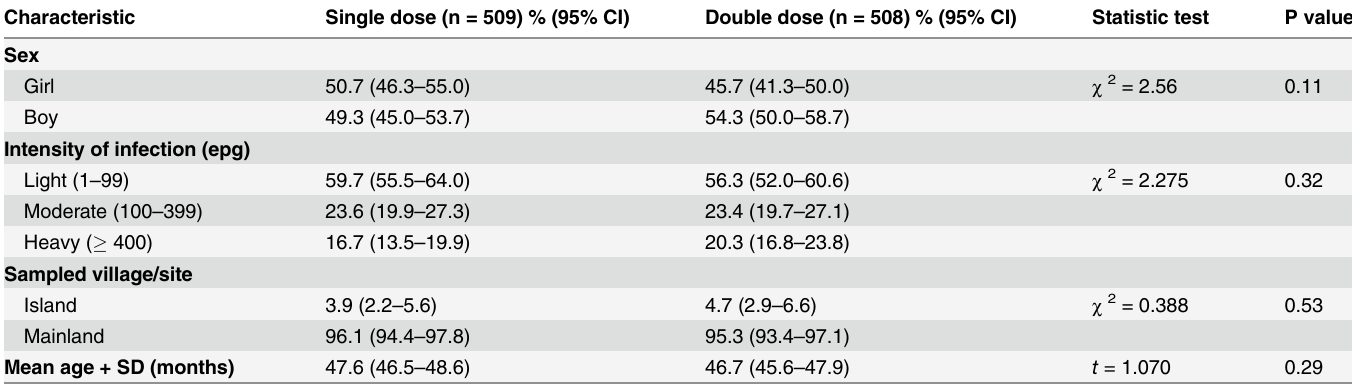
Table 1. Baseline characteristics for preschool-age children who were infected with Schistosoma mansoni and who were randomized to single and double dose treatments (n = 1017).